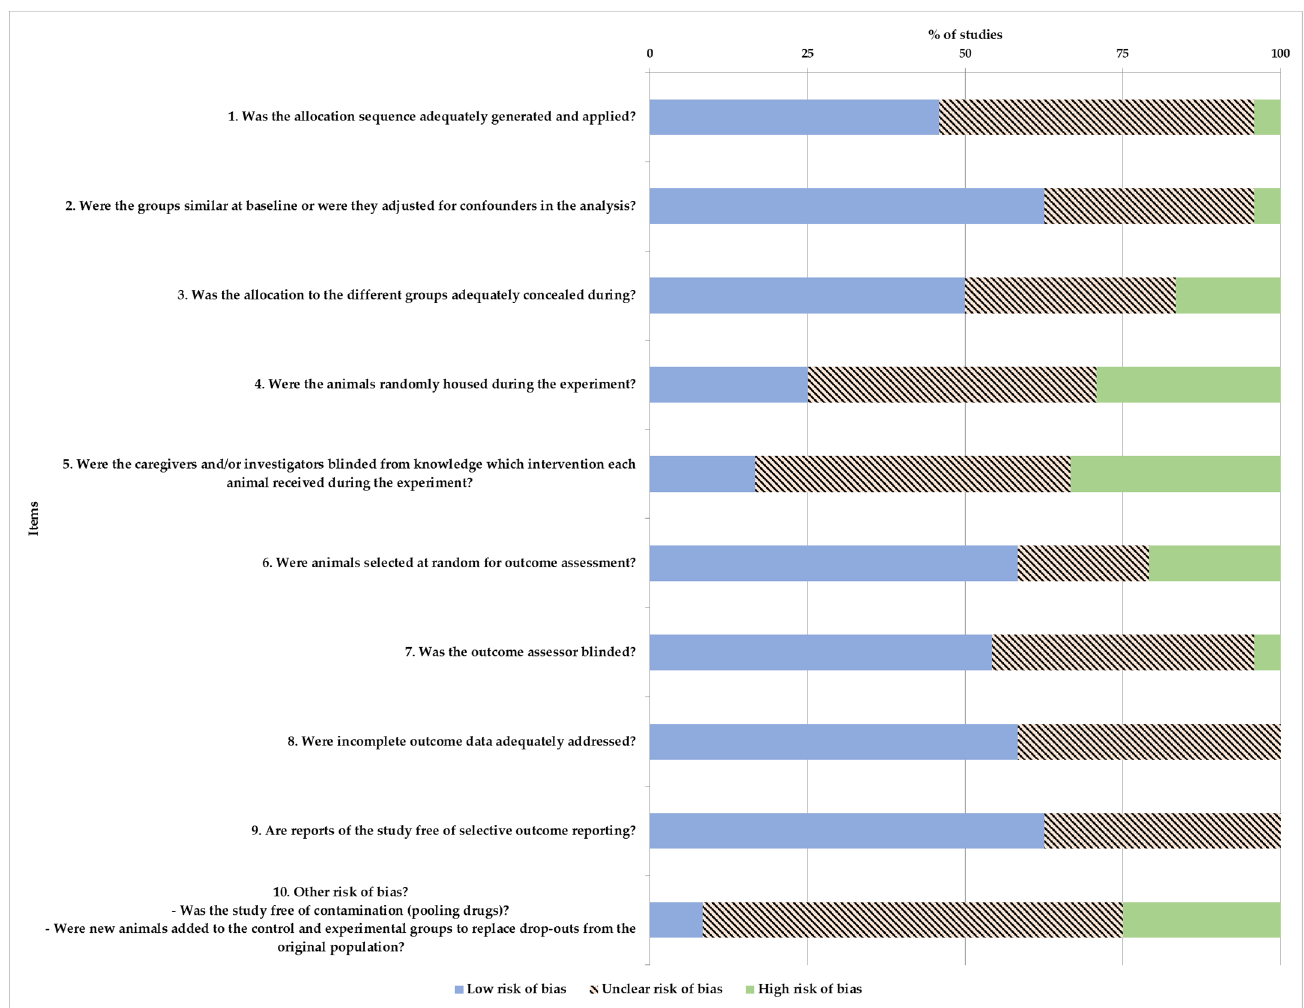
Figure 3. Risk of bias distribution according to Systematic Review Centre for Laboratory Animal Experimentation (SYRCLE) tool. Values are expressed by %.